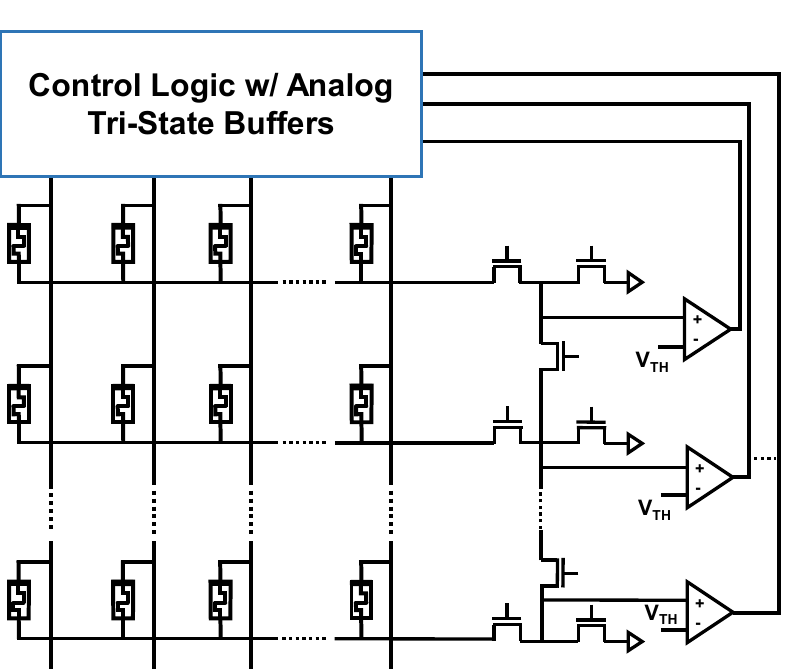
Figure 6. SIMPLY crossbar implementation. More than one comparator can be used to increase the computation parallelism.